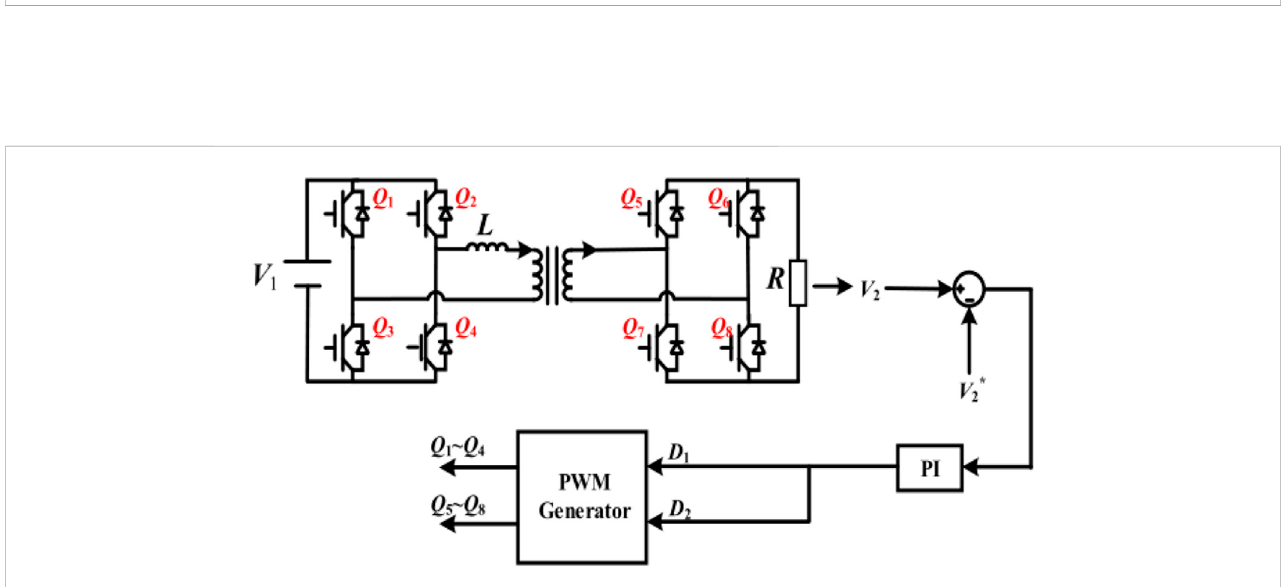
FIGURE 5 The control block diagram of DAB converter under optimized EPS